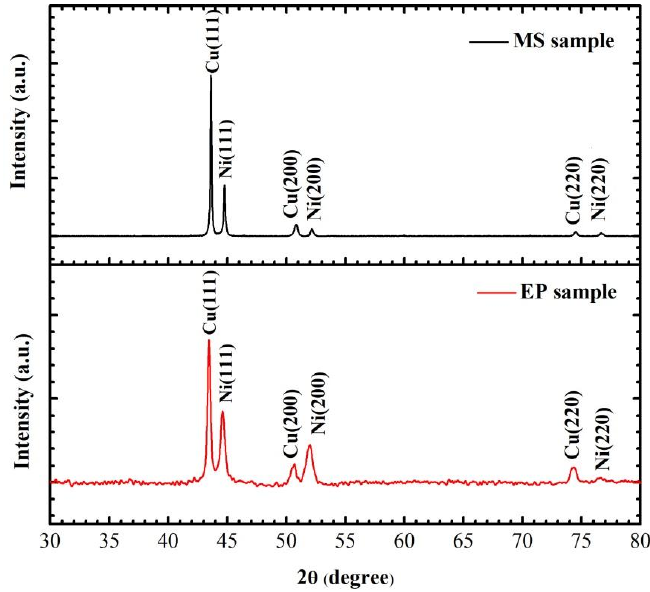
Figure 5. Comparison of XRD peaks of EP and MS samples.